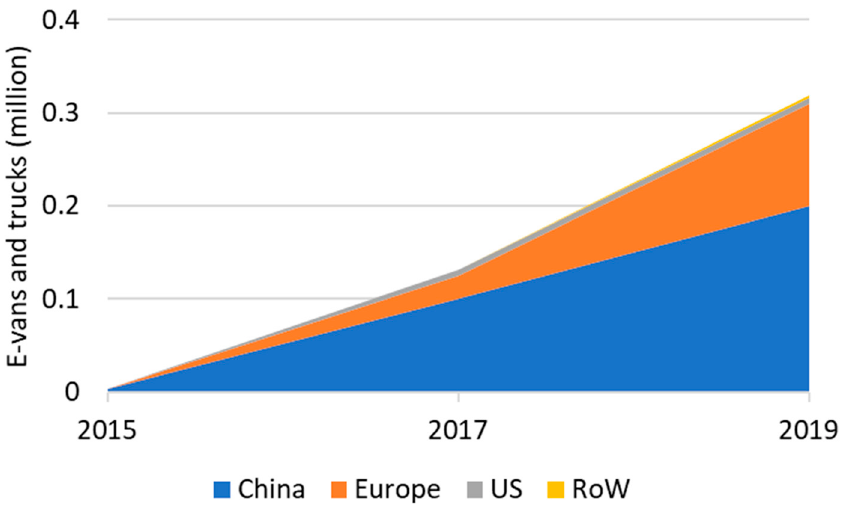
Figure 12. Development of electric vans and trucks, 2015–2019 (Data source: [56]).